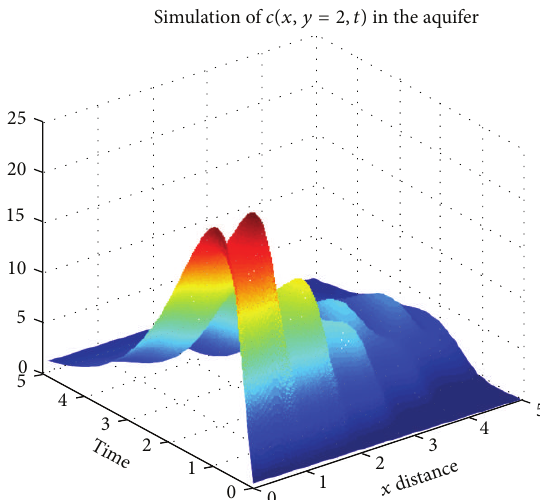
Figure4:SimulationoftheapproximatesolutionobtainedviaDTM for a fixed 𝑥 = 2 .